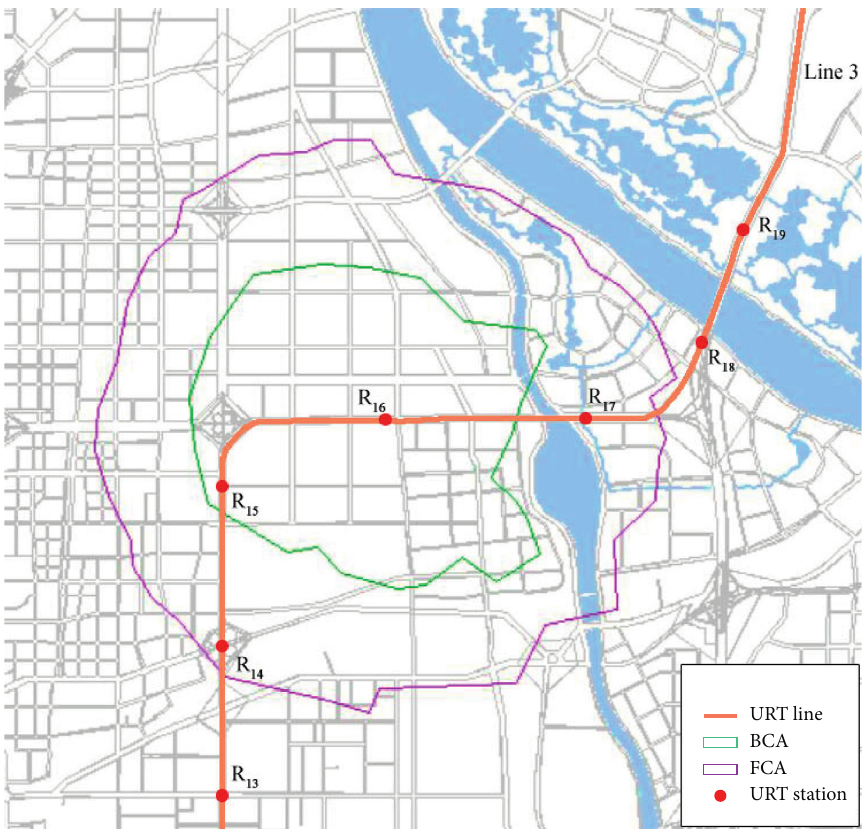
Figure 5: Catchment areas of Guangtaimen